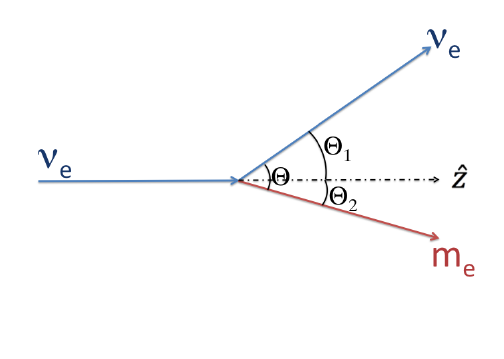
Figure 24: (Left) A model of the leading-order scattering of an atomic electron by an incident neutrino (e.g. a solar neutrino). Image from Ref. [ 33 ] . (Right) The degree of correlation between the ejected electron energy and the scattering angle with respect to the incident neutrino direction (private